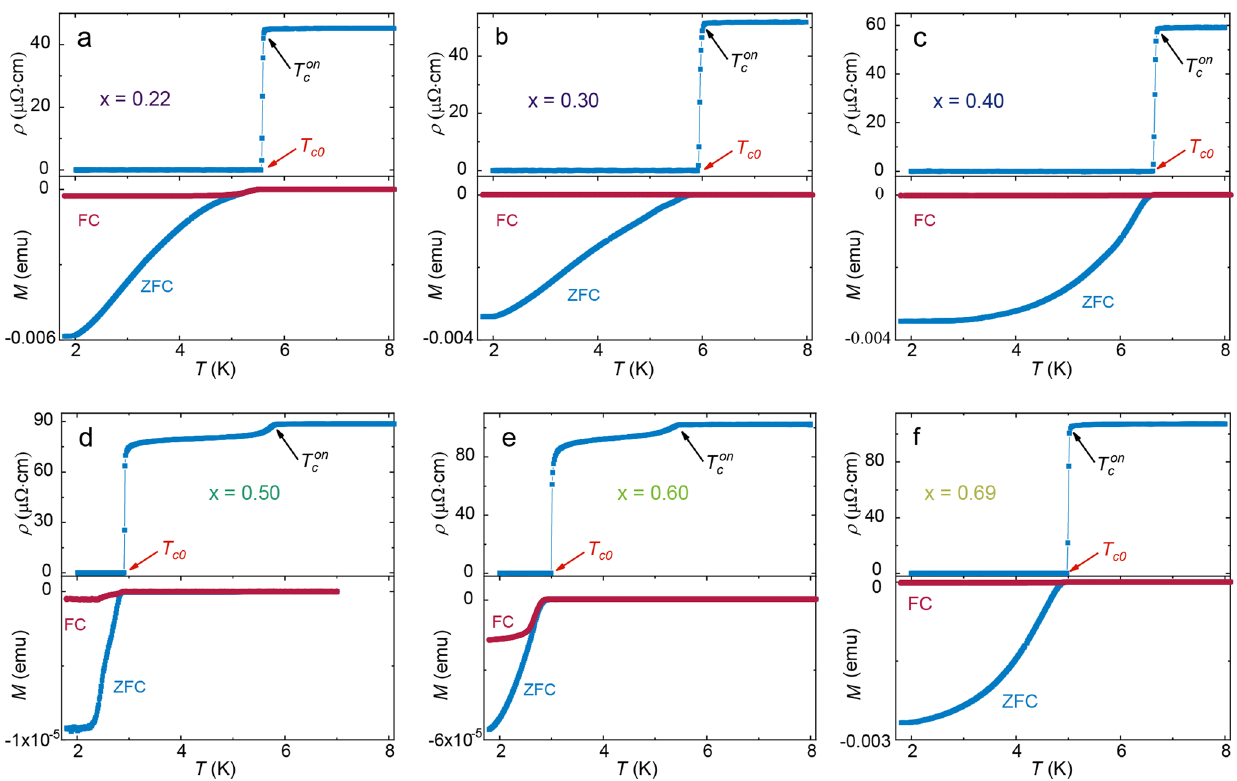
Fig. 2 Normal to superconducting phase transitions of the (TaNb) 1 − x (ZrHfTi) x fi lms. a – f The temperature dependence of the resistivity and the magnetization curves for both zero- fi eld cooling and fi eld cooling (2 mT) for x = 0.22, 0.30, 0.40, 0.50, 0.60, and 0.69, respectively.